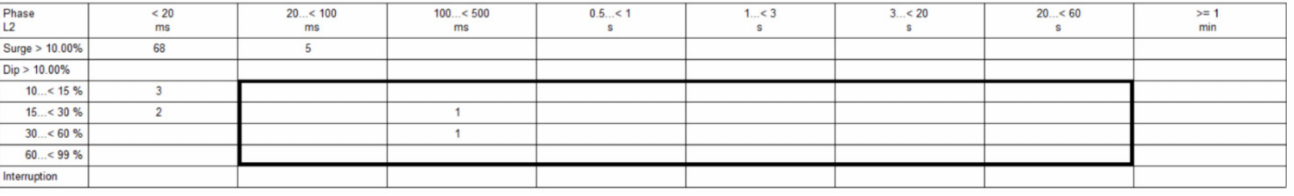
Figure 13. Summary of the number of voltage dips in the L2